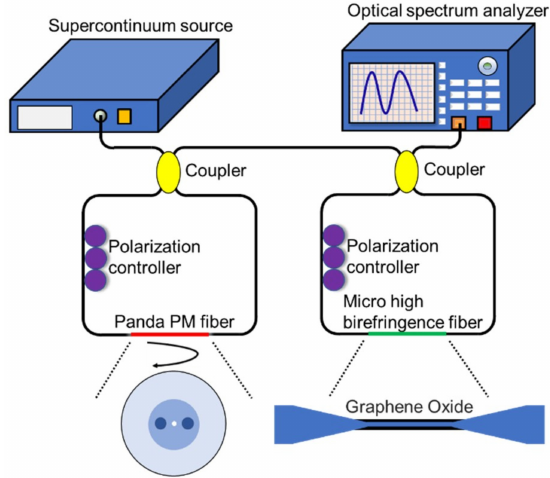
Figure 1. The schematic of the sensing system proposed based on